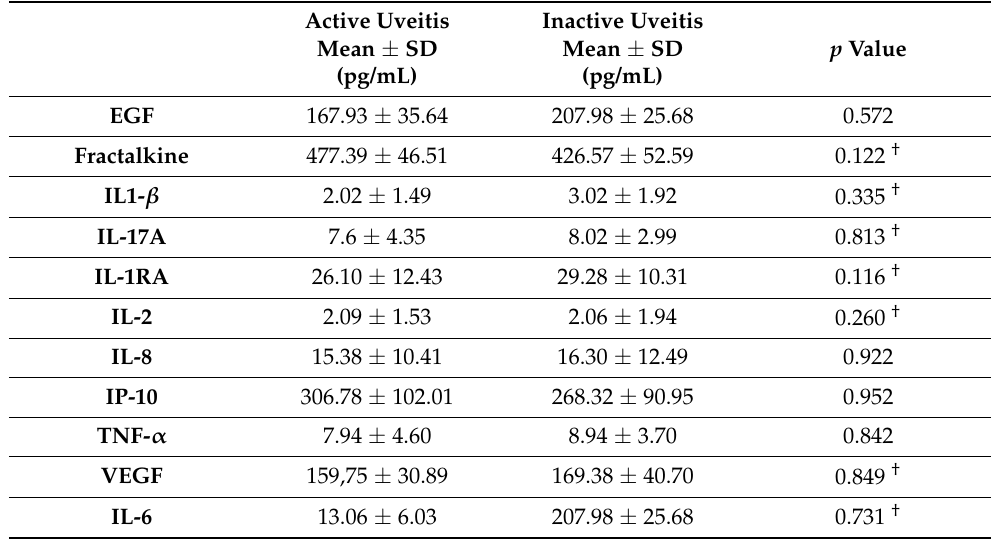
Table 3. Cytokine and chemokine plasma levels according to uveitic